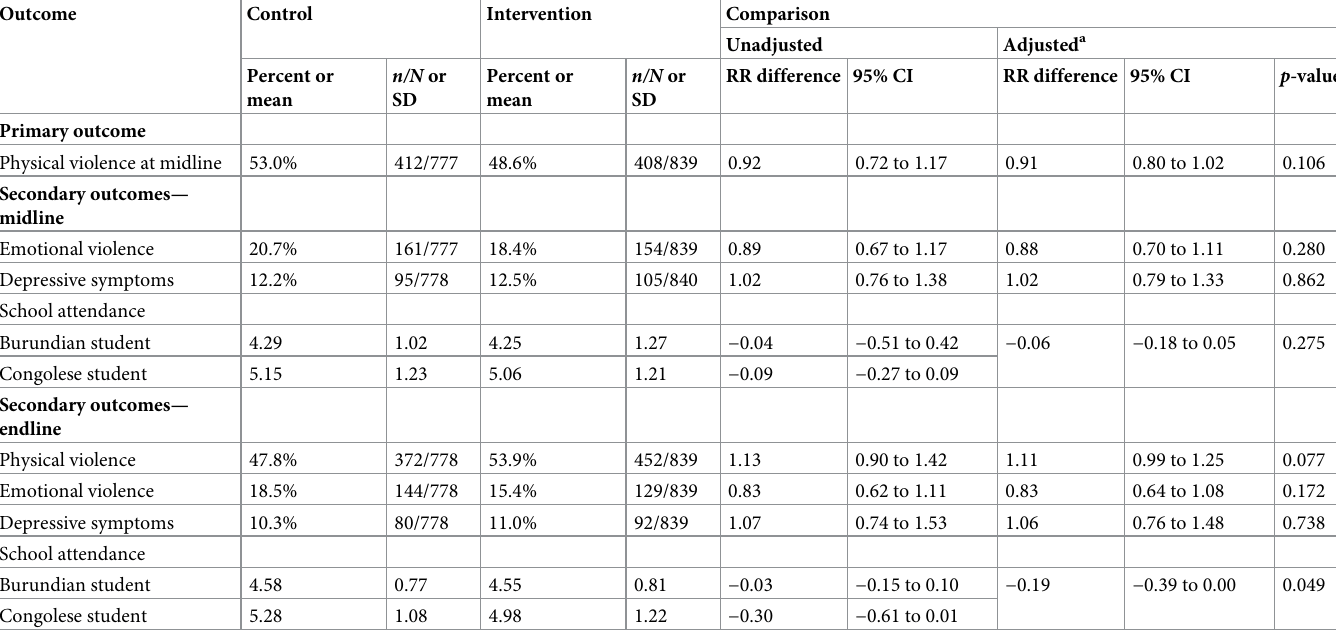
Table 3. Main trial results.